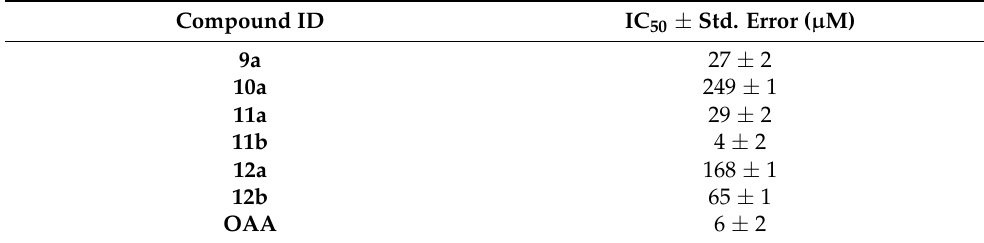
Figure 6. Oxalamic acid derived from 3-aminopyridine ( upper lane ) and 2-aminopyridine building blocks ( lower lane ). Table 3. N -(pyridine-3-yl)oxalamic acid derivatives 9a – 11b . N -(pyridine-2-yl) oxalamic acid derivatives 10a – 12b . Data fit with GRAPHPAD PRISM 5. Standard error of the fit given in µM. IC 50 diagrams, including the fit and standard deviations of the individual experiments ( n = 3), are depicted in the Supplementary Materials.